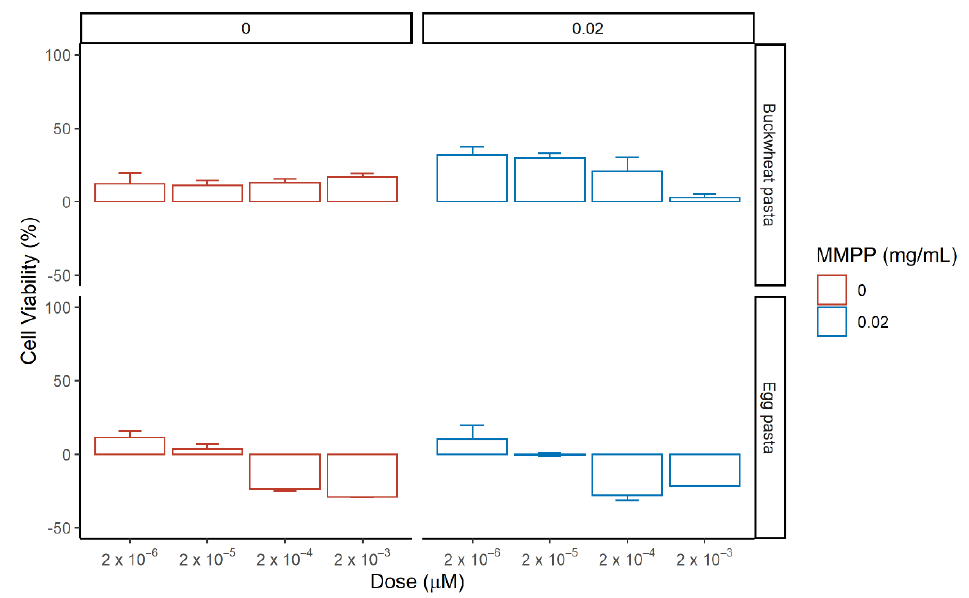
Figure 6. Effect of the pasta-derived carotenoid-enriched fractions on the cell viability of HEK-293 in the absence (left, red) or presence (right, blue) of MMPP after 72 h incubation. Reported values correspond to mean of the difference in cell viability between tested phytocomplexes and reference (medium in red, and MMPP in blue) with standard error over three biological replicates. The percentage of cell viability was calculated using the ratio Abs TEST /Abs CTRL .